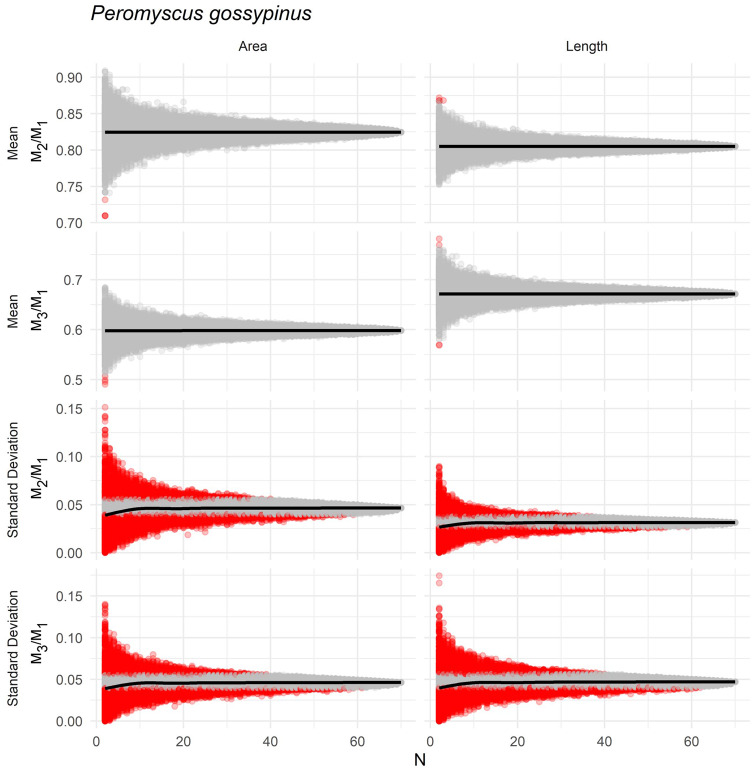
Relationship between sample size and estimates of mean and SD of ratios calculated to study the ICM (area) or MMC (length) based on resampling complete molar rows of P. gossypinus. Each gray point is one of 10,000 pseudoreplicates sampled at N sample size. Black line indicates the mean value calculated from pseudoreplicates. Red points indicate pseudoreplicate samples whose mean or SD is outside the 95% CI around the observed value calculated for the complete N = 70 sample.